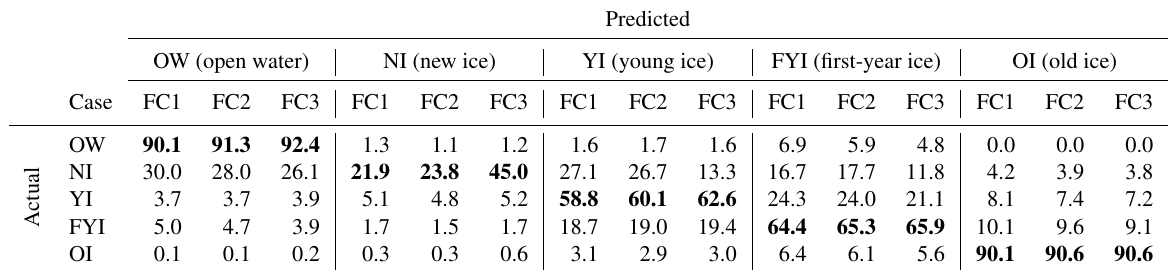
Table 3. Confusion matrix of the five-class RF classifier which was trained with and applied to the DS1 winter dataset. The bold font indicates where the classification was done correctly.